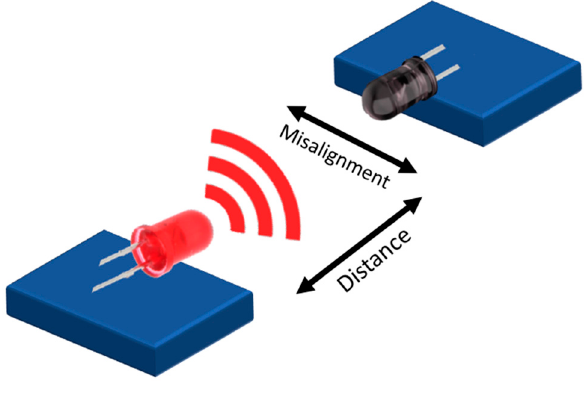
Figure 10. Distance and misalignment test layout.